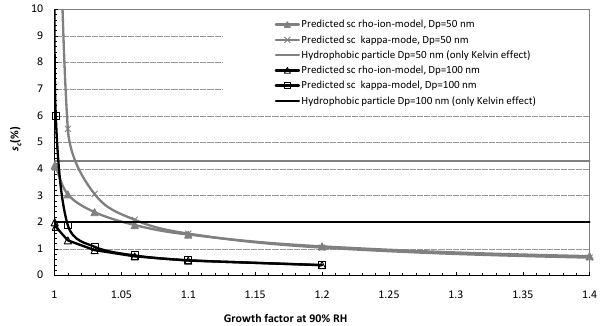
Fig. 8. Comparison of κ R model (a) and ρ ion model (b) to CCNC data for the K-puszta winter sample. In Fig. 7b the ρ ion model is shown both assuming water surface tension and fitting the surface tension to the data. In (a), the error bars along the 1:1 line represent typical uncertainties of the experimental s c from the CCN